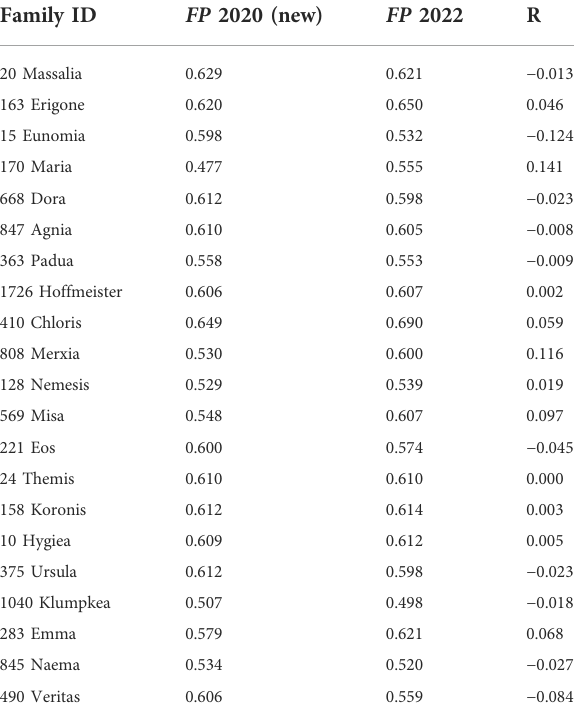
TABLE 5 Table shows the Fp ’ s metrics percentual comparison R between Carruba et al. (2020) machine learning algorithms applied to an updated database (displayed in the second column) and the current machine learning algorithms generated by genetic algorithms (column FP